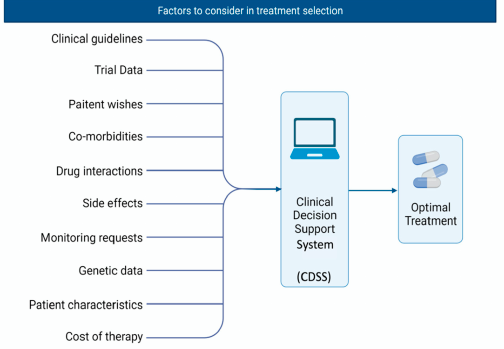
Figure 2. Depiction of an ideal clinical decision support system